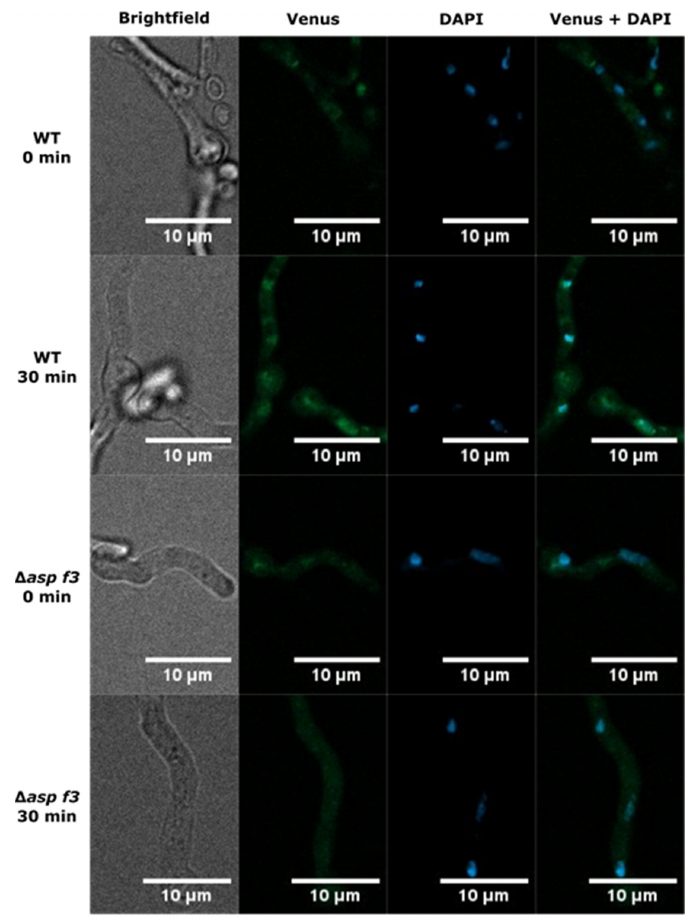
Figure 6. Subcellular localization of AfYap1 VENUS . Aspergillus fumigatus conidia were incubated in Czapec Dox for 10 h until germination. Both strains were challenged with 2 mM H 2 O 2 for 30 min before microscopy. The VENUS-tag shows a green fluorescent signal for the target protein AfYap1, nuclei were stained with NucBlue™ Live ReadyProbes™.